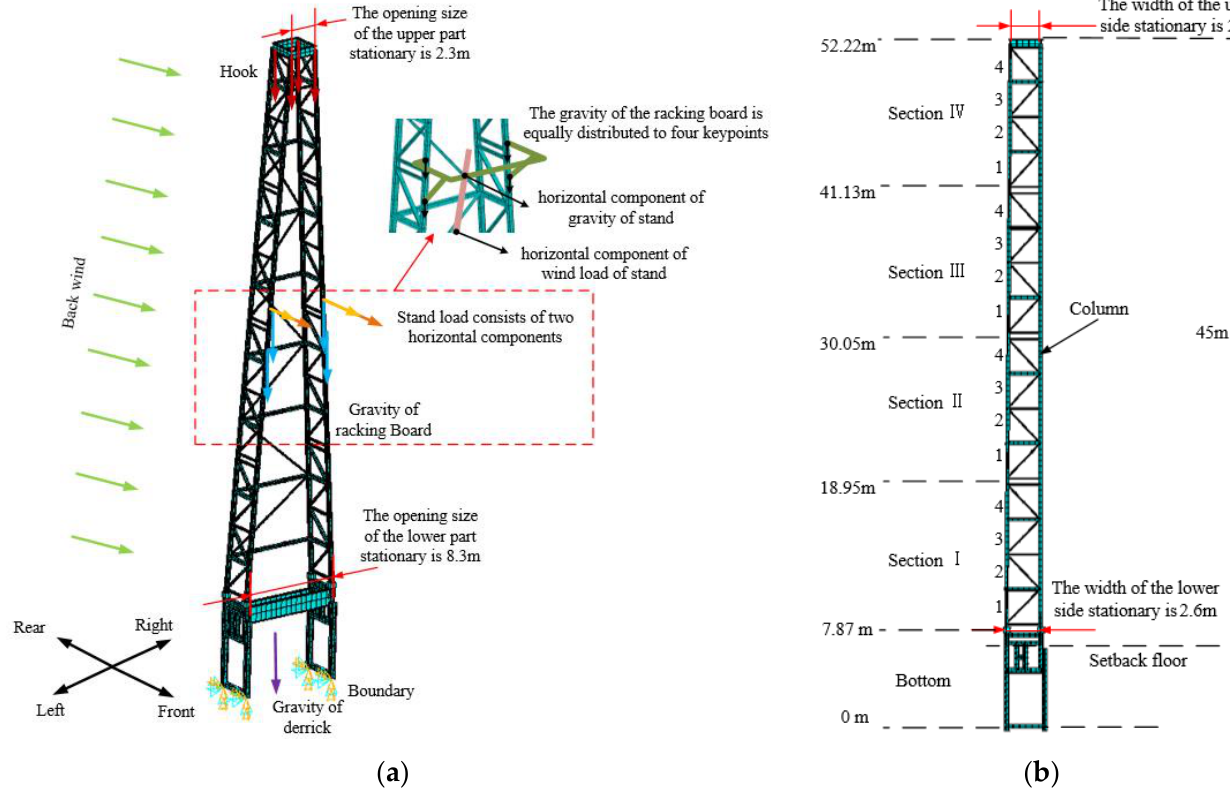
Figure 3. The numerical model of derrick. ( a ) The oblique view of derrick. ( b ) The side view of derrick.